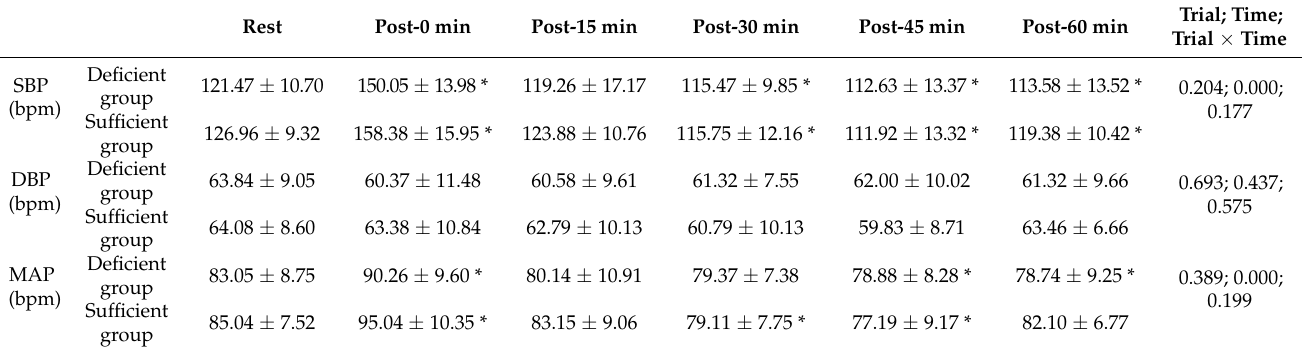
Table 2. The changes in blood pressure following acute maximal exercise in different vitamin D